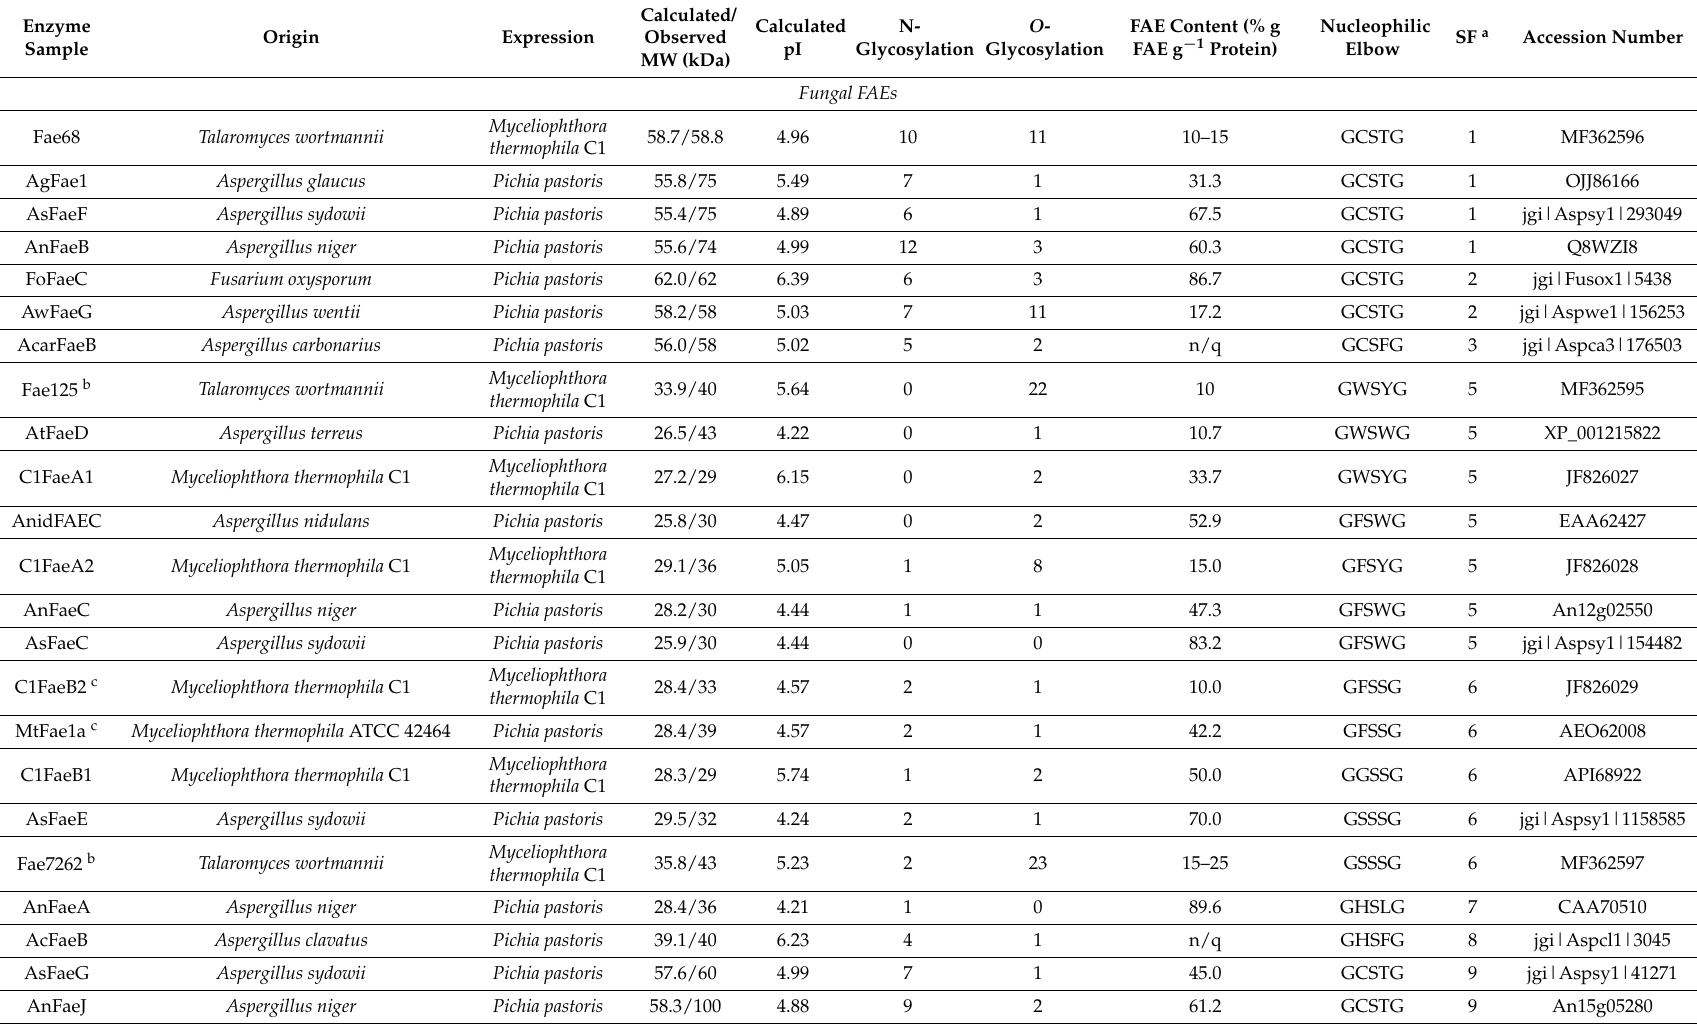
Table 1. Characteristics of feruloyl